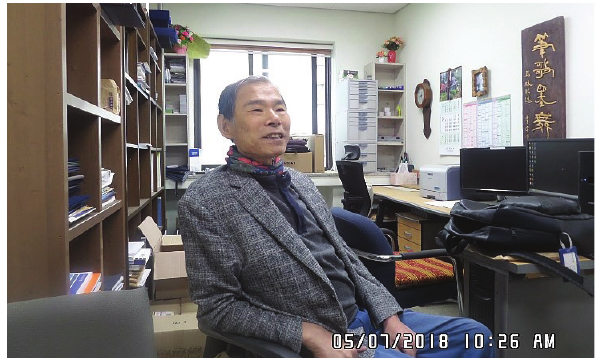
Figure 2. Picture of Dr. Hyun-Sul Lim in May 7, 2018 in his room